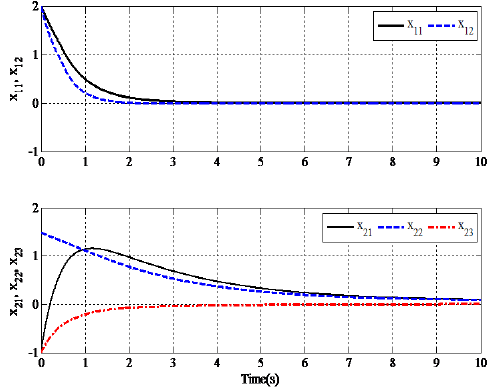
Fig. 1: Closed-loop state responses of the intercon- nected switched Takagi-Sugeno systems.